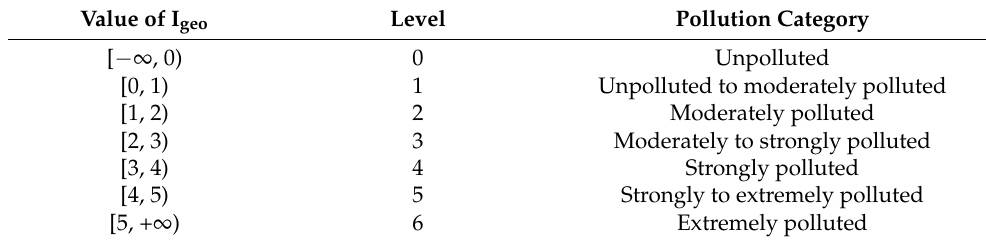
Table 2. The value of I geo and the pollution